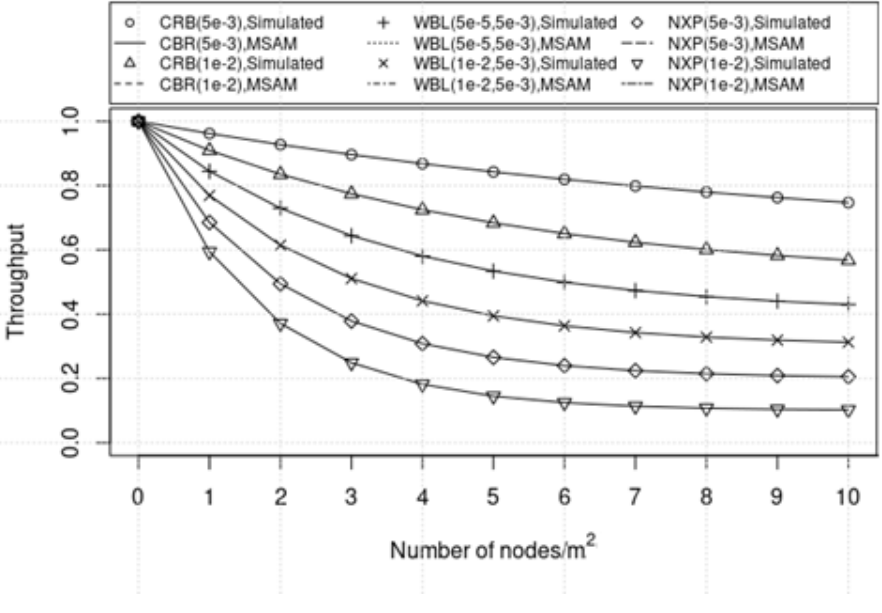
Figure 8. Throughput vs. network density.